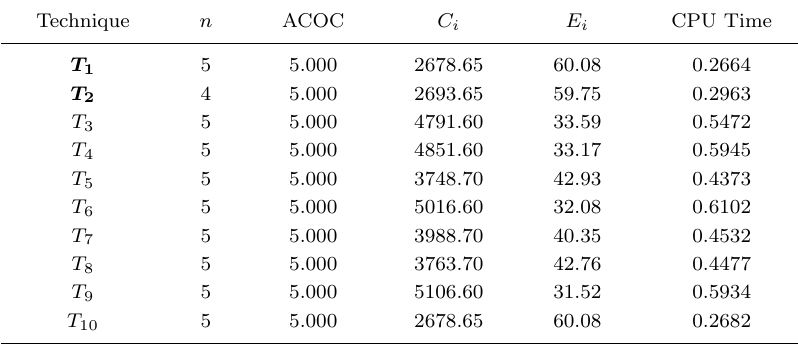
Table 3. Comparison of performance of techniques for Problem